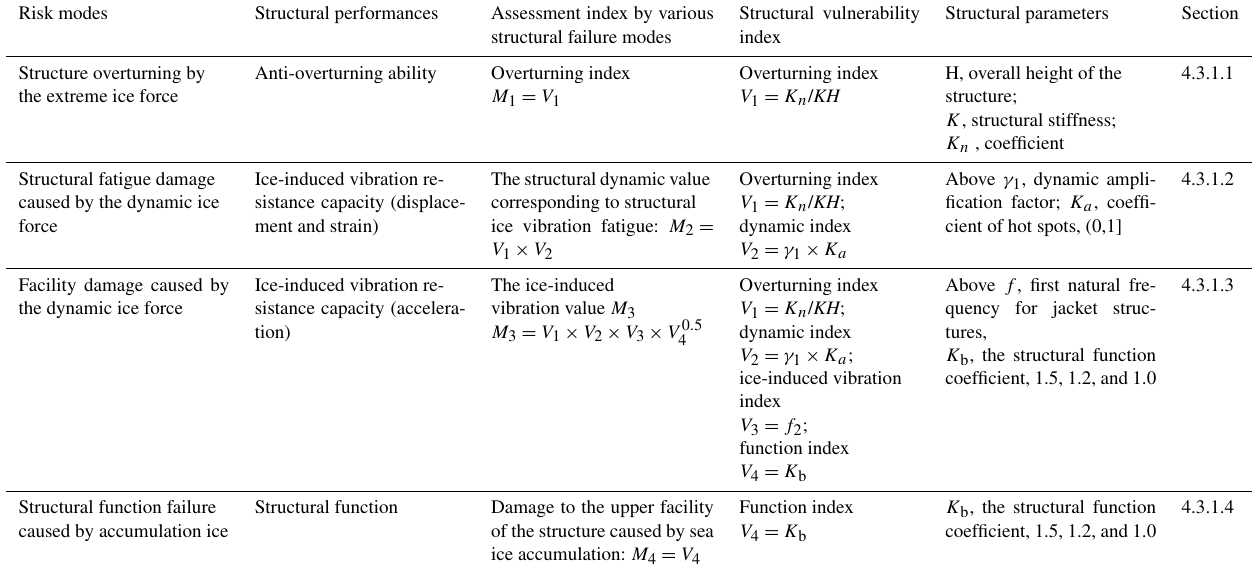
Table 3. Sea ice disaster risk modes of oil platforms and corresponding vulnerability indices.